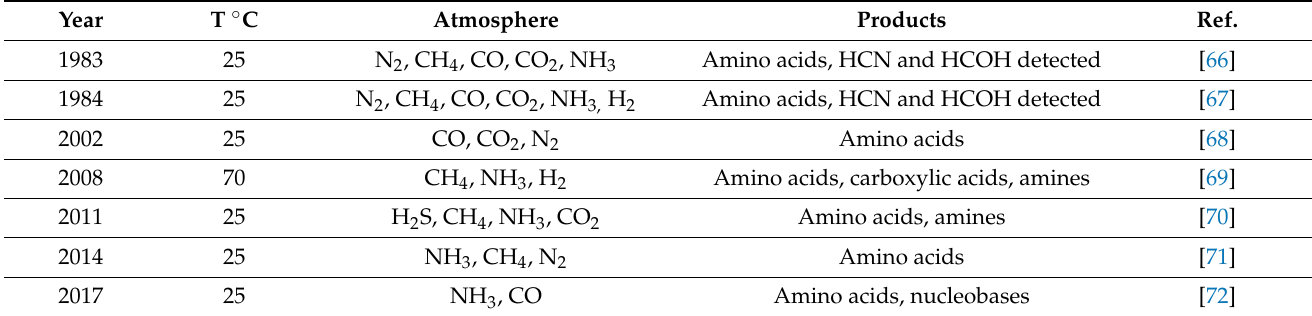
Table 2. Biogenic molecules produced from electric discharge experiments in pristine Earth.